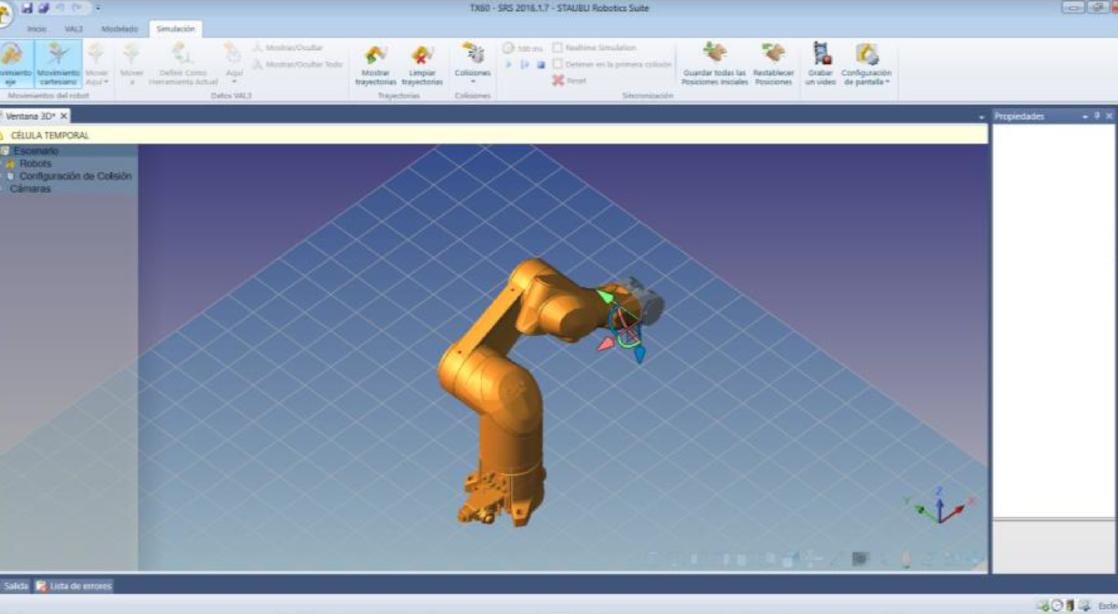
Figure 13. Stäubli Robotic Suite environment showing the rotation of the extreme joint of the robot. Table 2. Minimum number of movements required for the